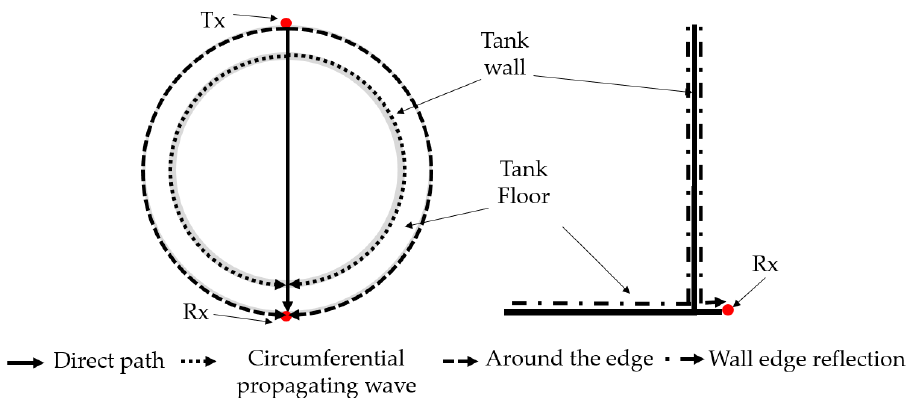
Figure 5. Primary wave paths for wave propagation in the tank.